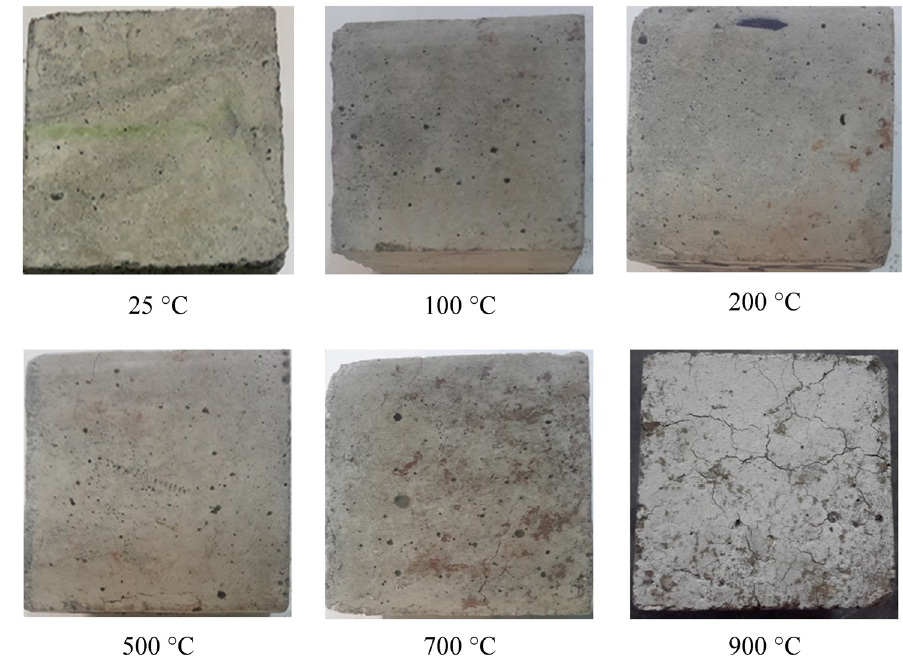
Figure 7: Apparent changes in heated concrete